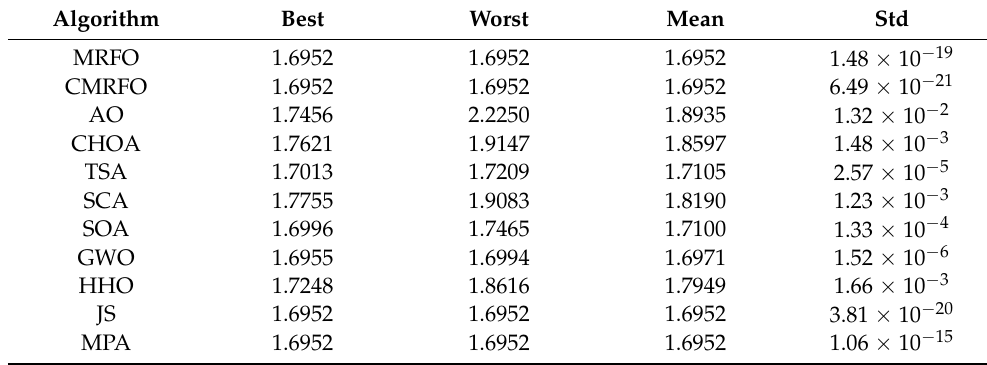
Table 15. Results of all 11 algorithms after 30